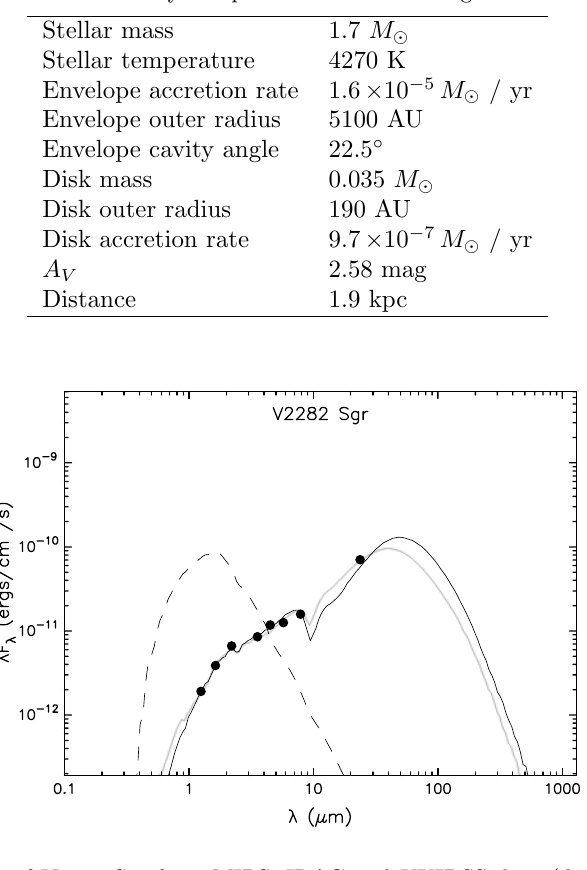
Fig. 7. SED of V2282 Sgr from MIPS, IRAC and UKIDSS data (dots). The best- fitting disk model (Robitaille et al. 2007) is overplotted to the data with a continuous line. The dashed line is SED of the stellar component model (Table